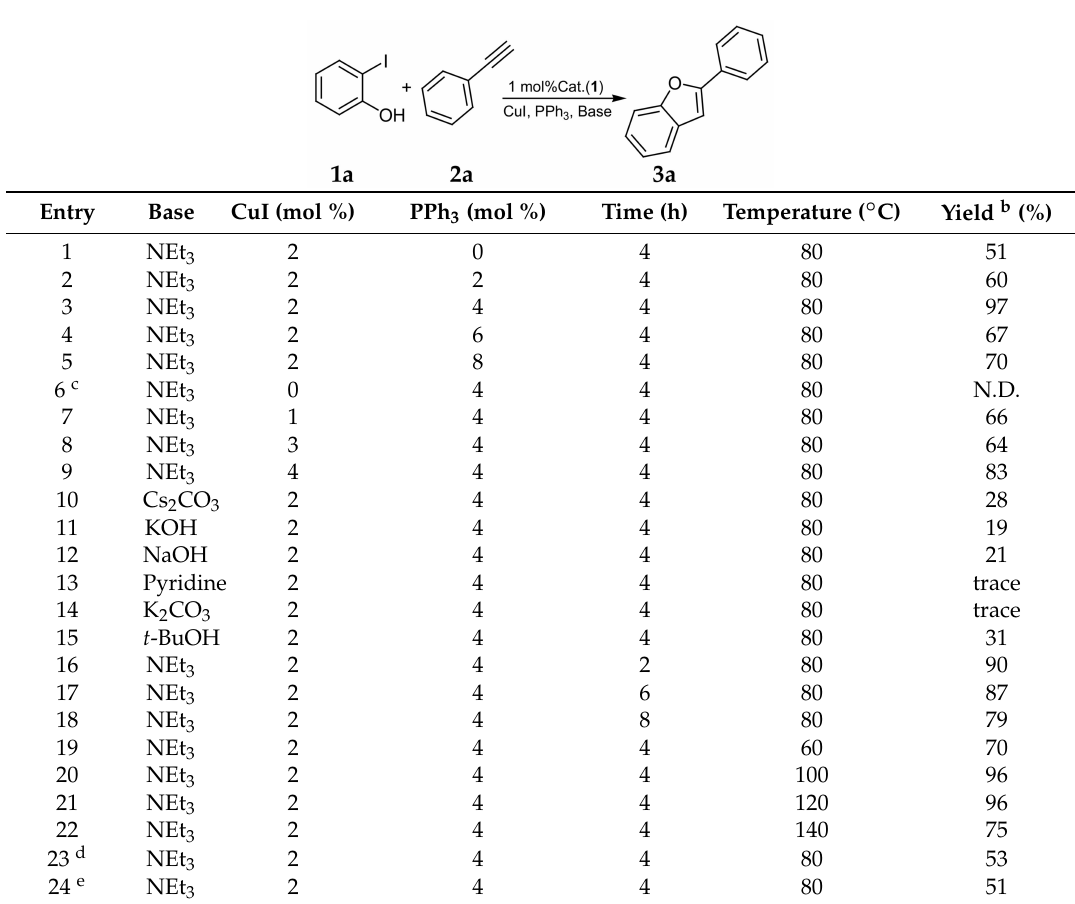
Table 1. Optimization of reaction conditions a .